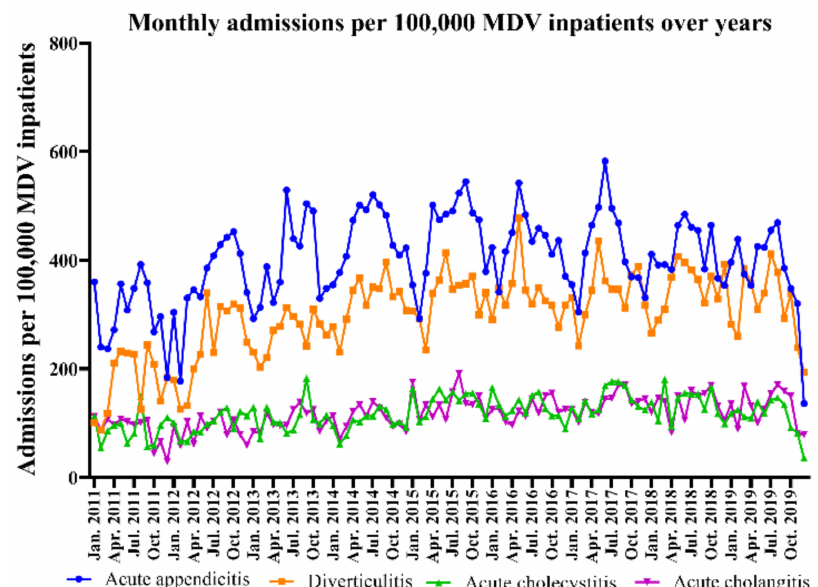
Figure 2. Monthly admissions per 100,000 MDV inpatients over the years. MDV, medical data vision.